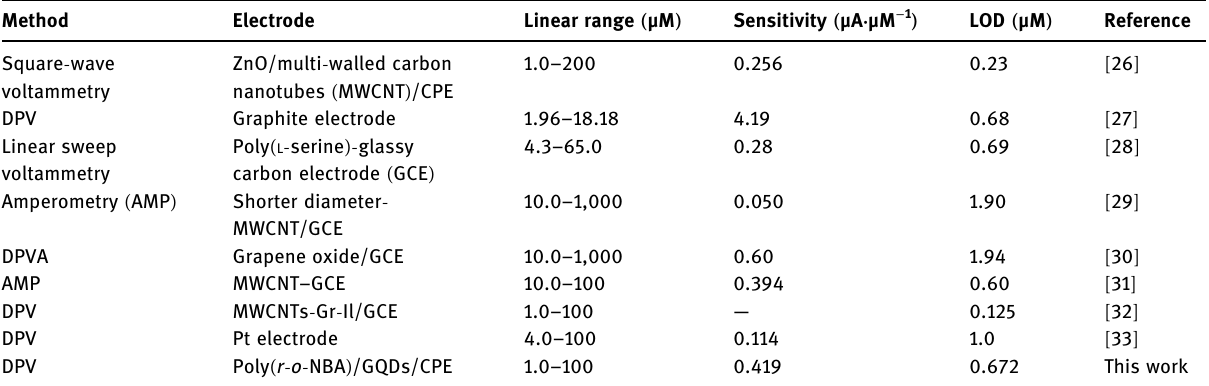
Table 1: Analytical parameters of several reported electrodes for the determination of NPX